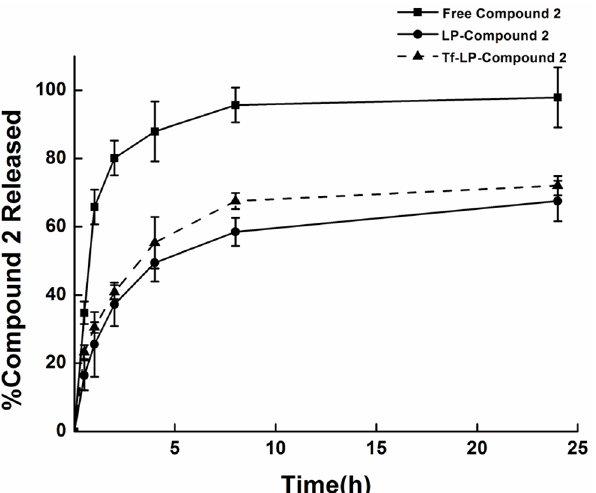
Fig 5. Cytotoxicity tests of various formulations in various cells. (A) HeLa cells (B) HepG2 cells (C) HEK-293T cells. Data represent the mean ± standard deviation (n = 6) ( * p < 0.05, ** p < 0.01: Tf-LP-Compound 2 versus LP-Compound